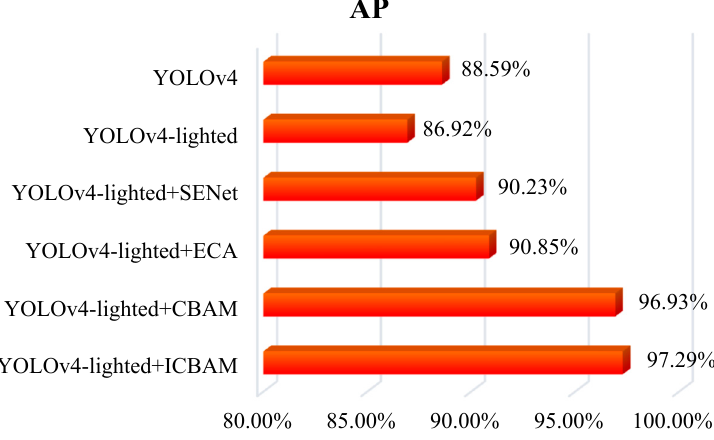
Figure 8. AP values of different recognition models.